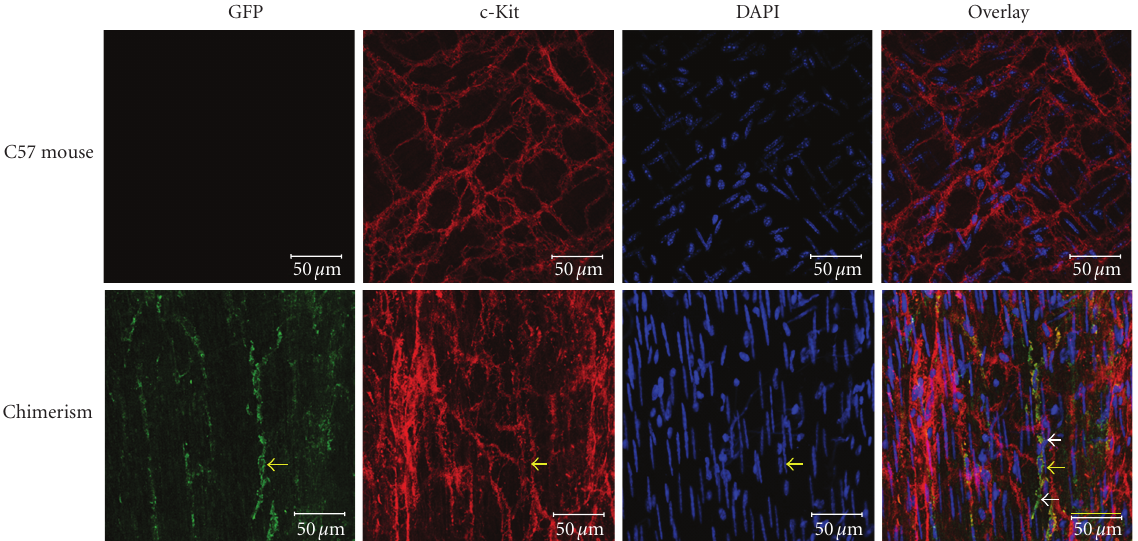
Figure 5: Representative immunofluorescent image of GFP and c-Kit double positive ICCs on whole mount preparation of small intestine. GFP protein was stained by FITC-labeled goat antirabbit IgG, and c-Kit was demonstrated by Cy3-conjugated goat anti-rat IgG. Upper panel: C57 mouse was used as negative control, in which there were no GFP signals in the intestine. Lower panel: GFP and c-Kit double positive cells were shown in chimeric intestine. Double positive cells could be found on the whole mount preparation, indicating that ICCs could be derived from BMDCs. Yellow arrow was indicated a double positive cell and white arrow directed to its two polar processes. Bar = 50 μ